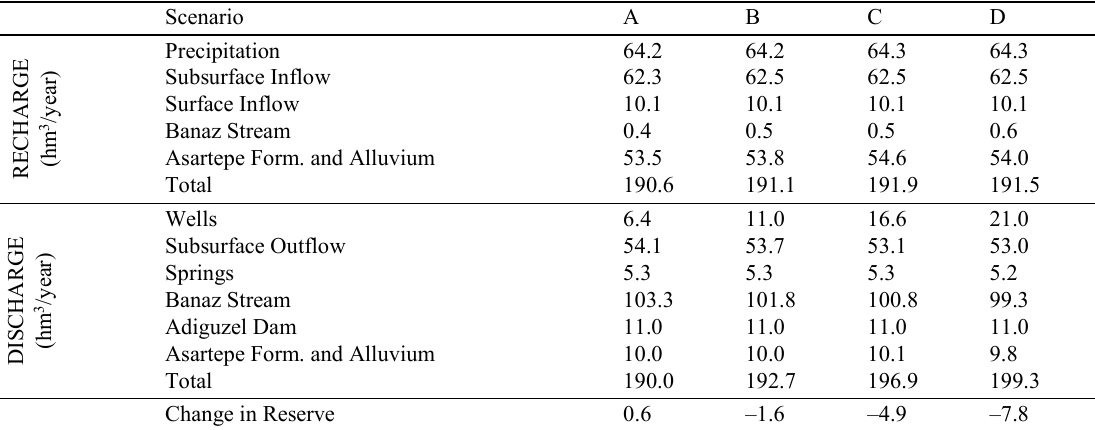
Table 1 Groundwater budget of the Ulubey aquifer